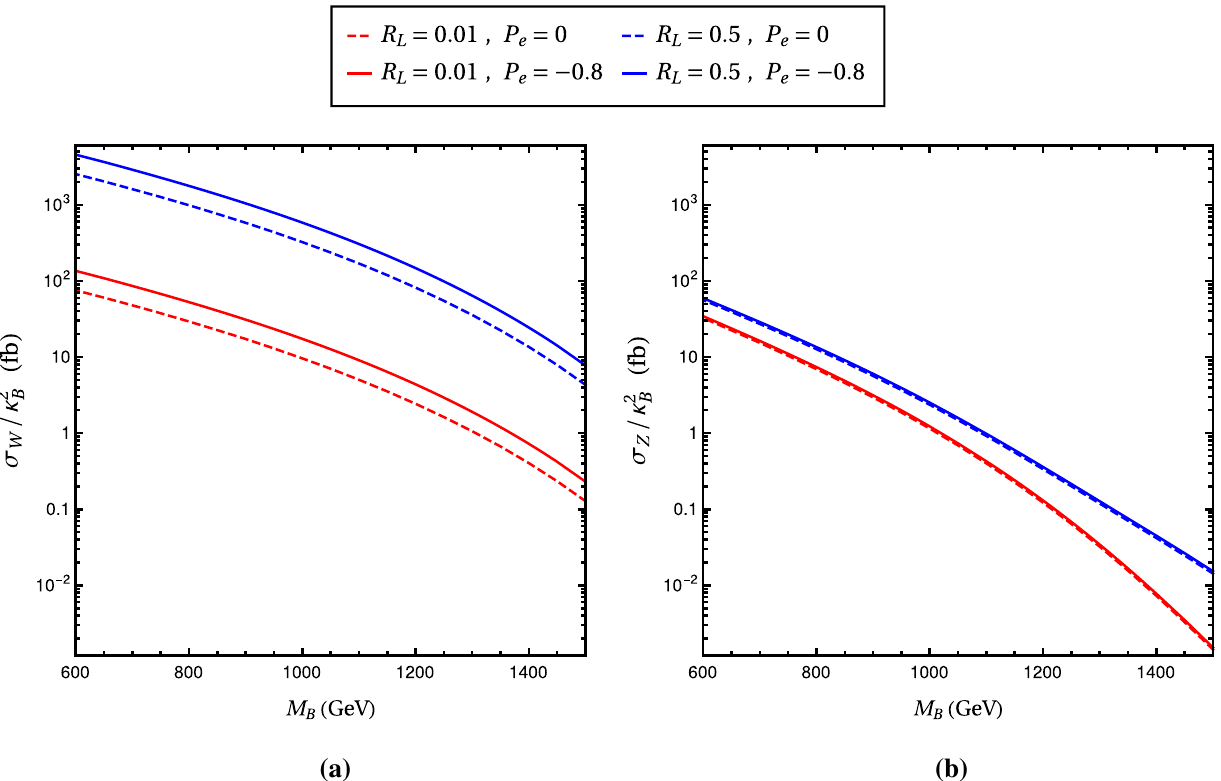
Fig. 3 The scaled cross sections of the processes e − p → W → ν B and e − p → Z → e − B as functions of M of e −